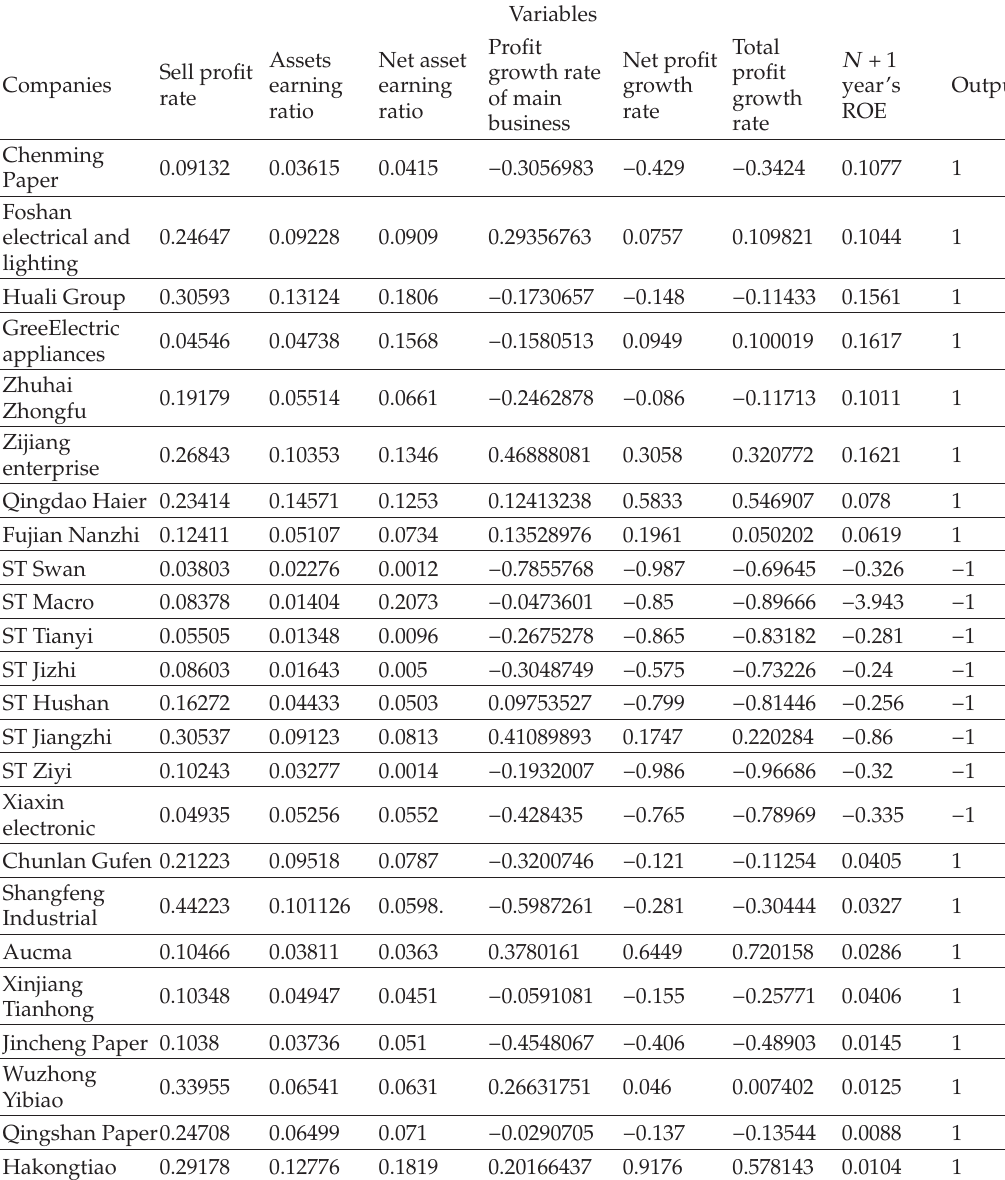
Table 1: The training